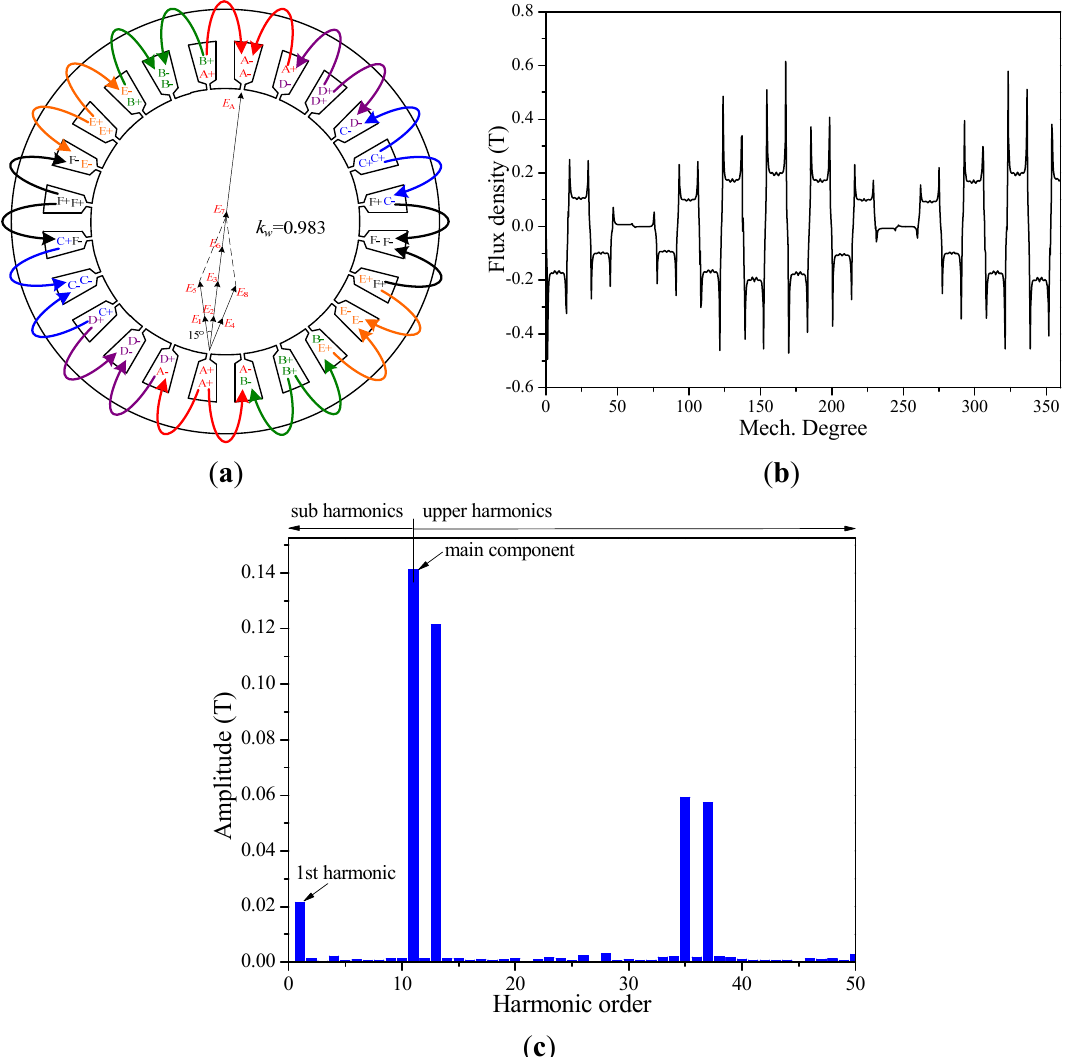
Figure 3. Winding arrangement and MMF harmonic analysis of the 24-slot all-teeth-wound asymmetric six-phase PMSM: ( a ) stator winding arrangement and the synthesized